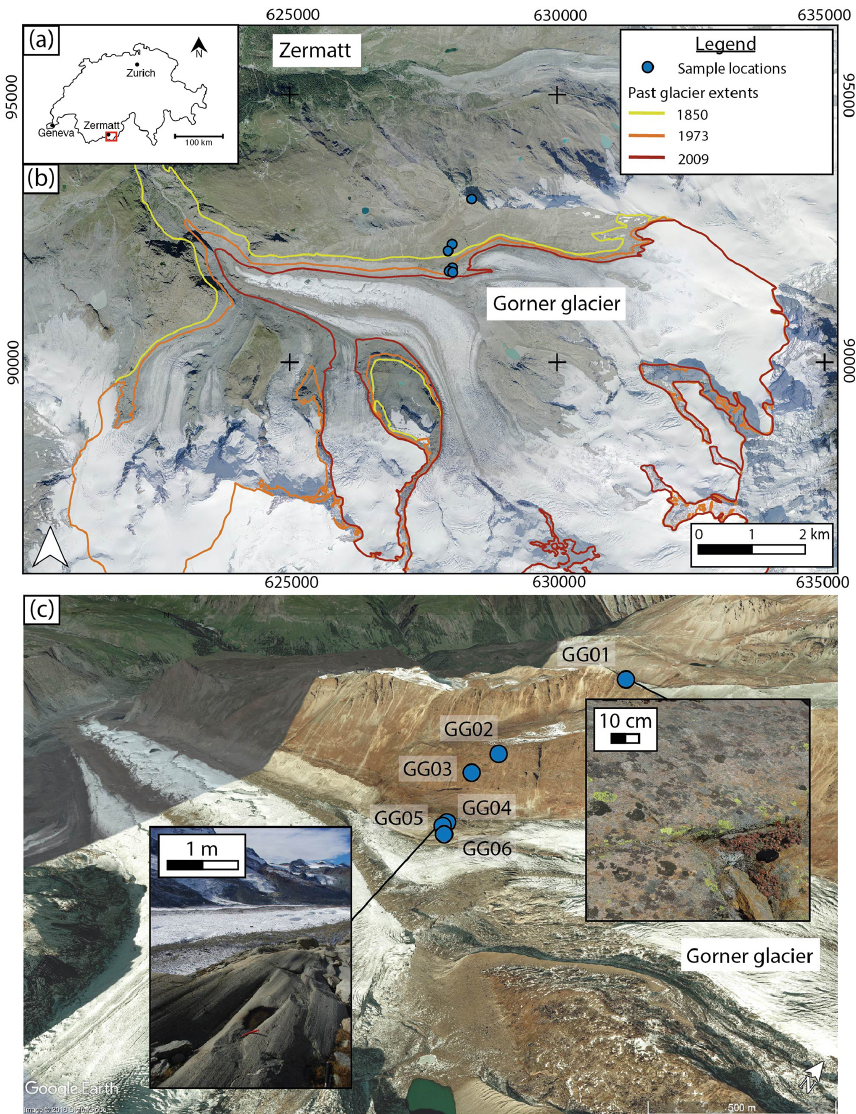
Figure 1. Study area and sampling sites on (a) regional, (b) glacier basin and (c) local scales. Panel (b) further depicts the glacier retreat history obtained from the Global Land Ice Measurements from Space initiative (GLIMS) (GLIMS Consortium, 2005a–f; Raup et al., 2007). The photo in the background is from the Swiss Federal Office of Topography and was taken in 2015. Panel (c) illustrates the difference in surface preservation with elevation and thus exposure